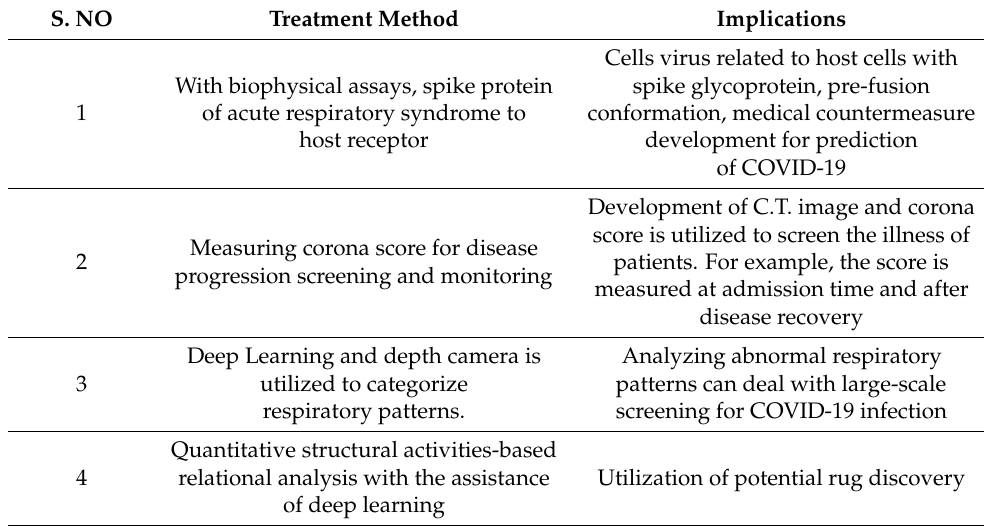
Table 2. Treatment processes and